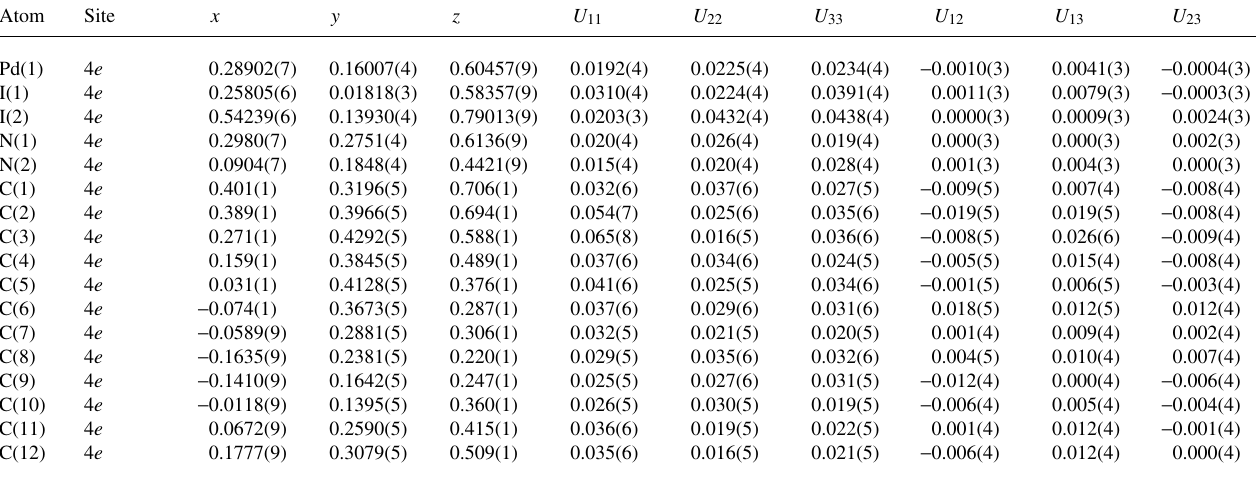
Table 3. Atomic coordinates and displacement parameters (in Å 2 )